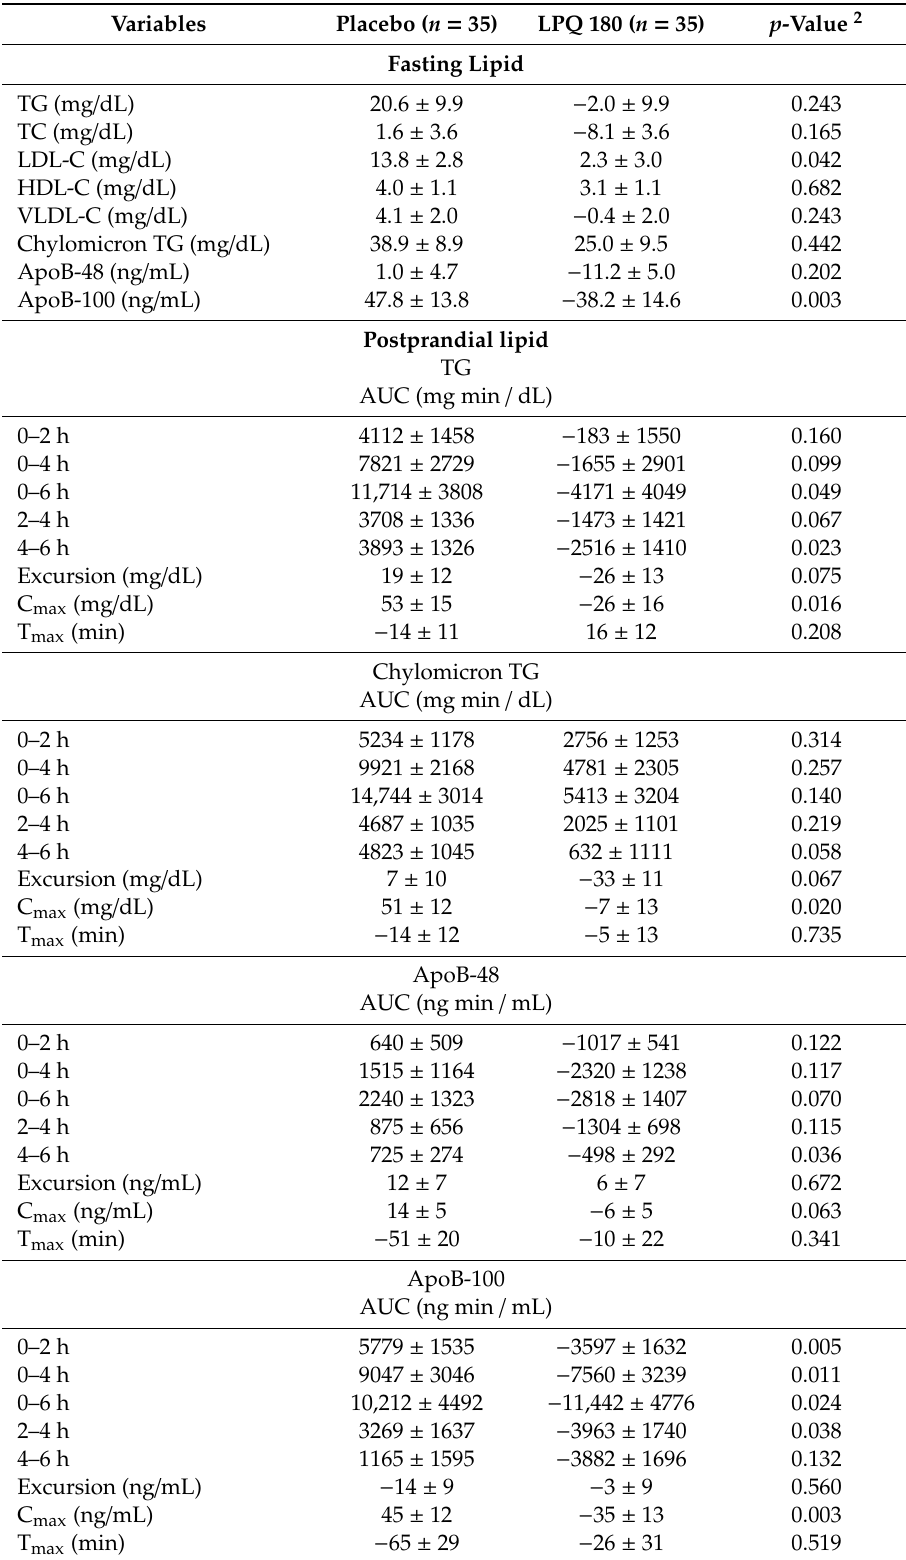
Table 2. Changes of summary valued of lipids after 12 weeks 1